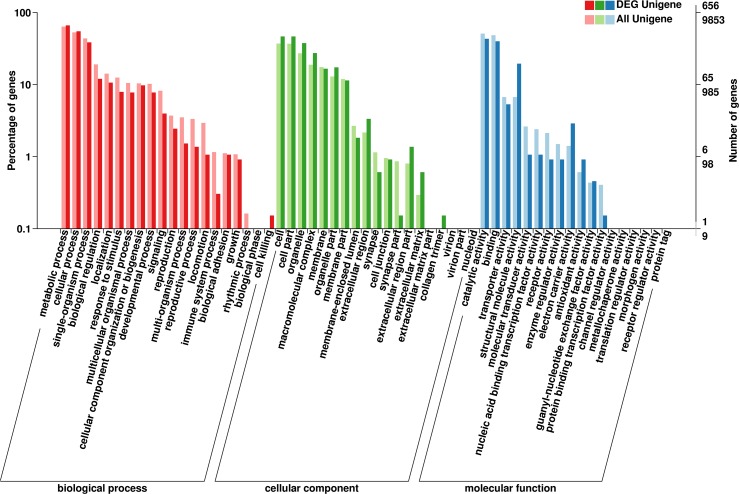
Distribution of differentially expressed genes annotated by GO subclasses.The X-axis shows three GO categories and subcategories. The Y-axis indicates numbers of differentially expressed genes.